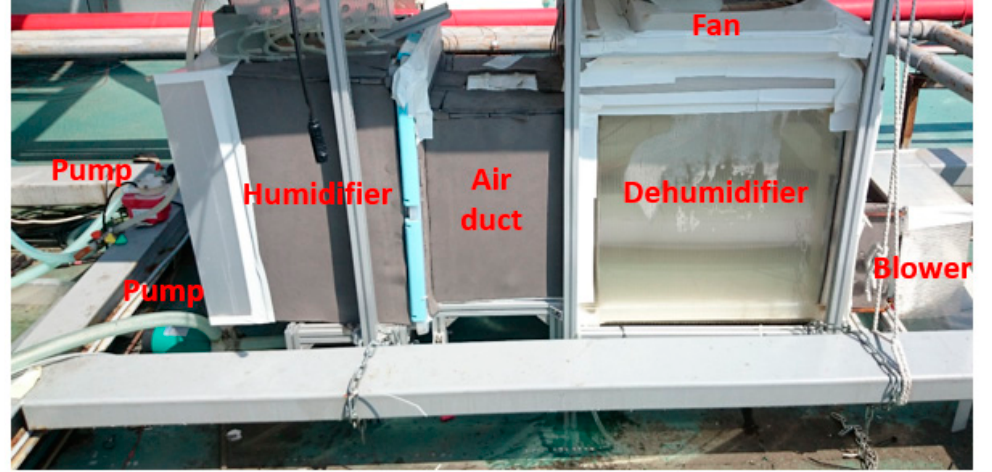
Figure 3. Photograph of the experiment setup.